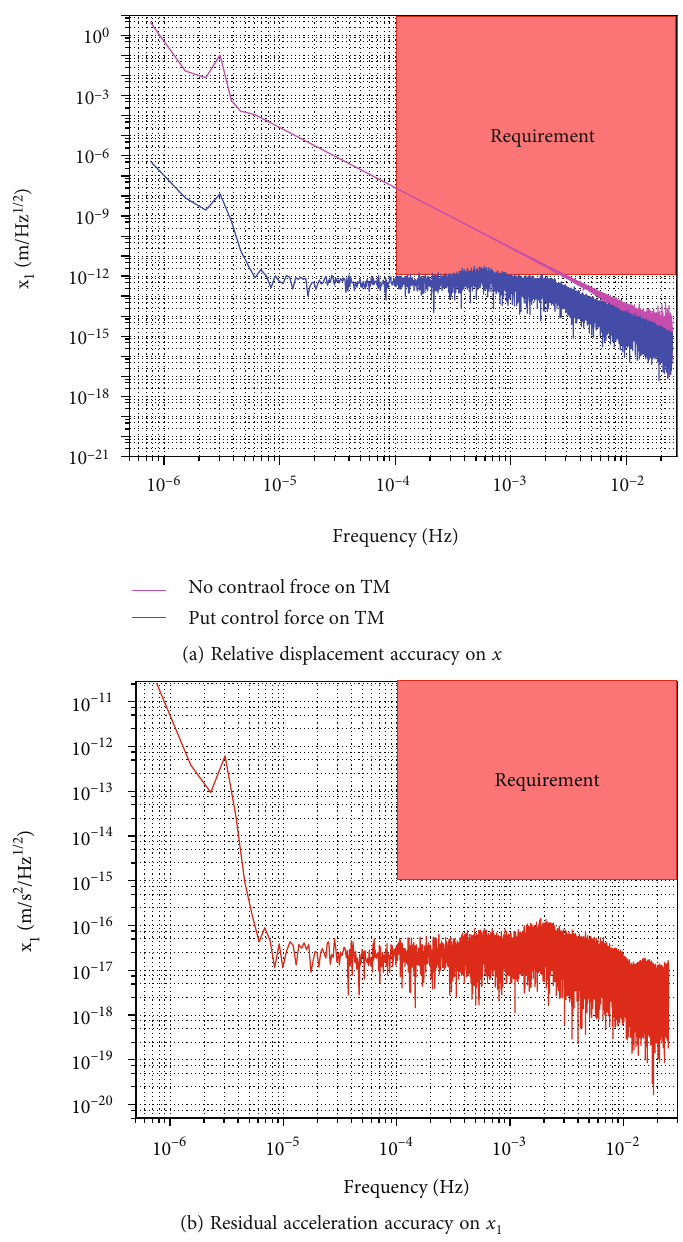
Figure 9: The displacement accuracy and residual acceleration accuracy of the relative motion on x